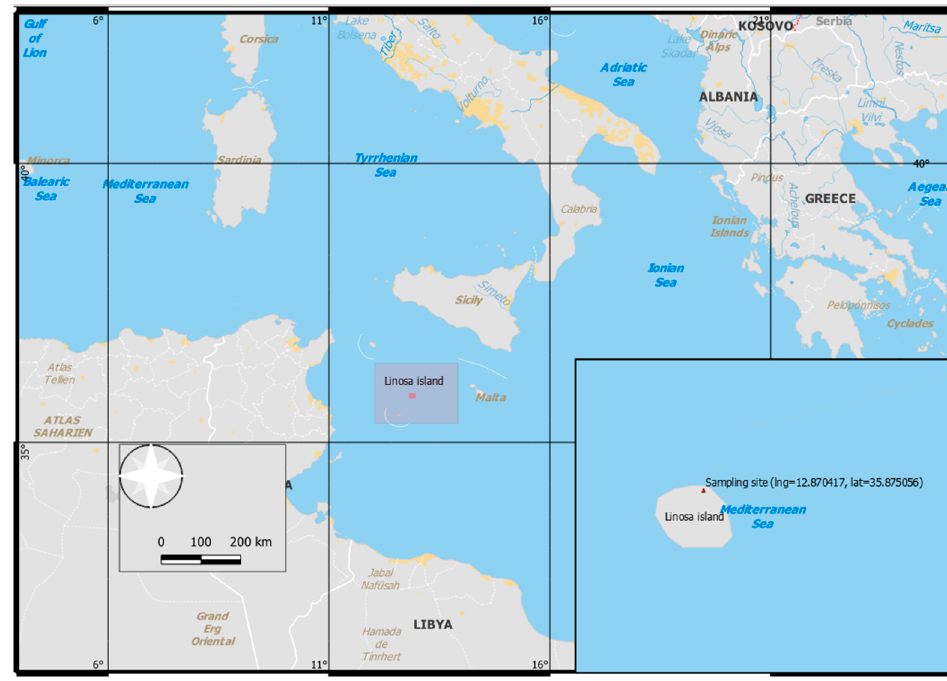
Figure 1. Location of Linosa Island (South Mediterranean; 35°52 ʹ 30.2 ʺ N 12°52 ʹ 13.5 ʺ E), with the study colony marked in red.